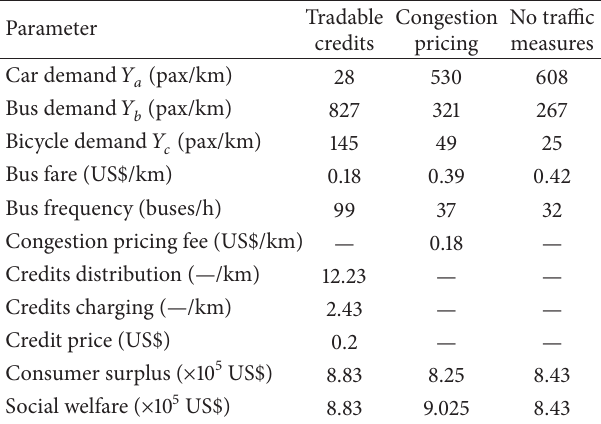
Table 2: Results of numerical simulations of